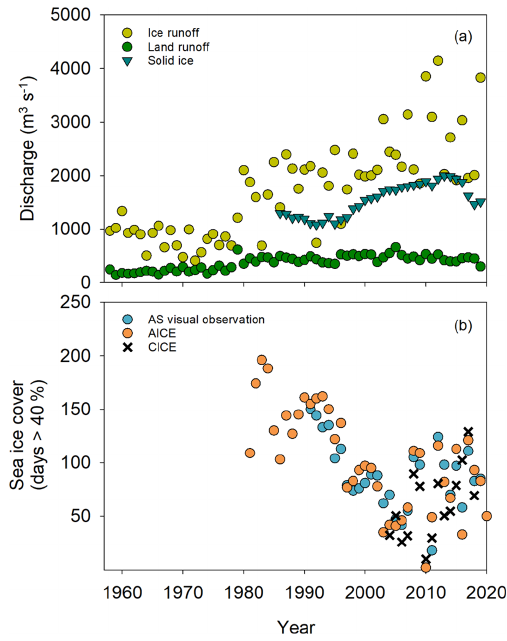
Figure 2. Developments in freshwater discharge and sea ice cover over time. (a) Freshwater discharge from the Greenland ice sheet divided into liquid from precipitation over land (land runoff), liquid derived from melt from the Greenland ice sheet and from glaciers (ice runoff), and ice derived directly from the glacier (solid ice) for the period 1960–2019. (b) Number of days with more than 40% sea ice cover from 1986 to 2019, derived from satellite measurements (AICE) by the sea ice model that provides inputs to the this study (the Community Ice CodE – CICE) and from visual observations at the Arctic station, Qeqertarsuaq